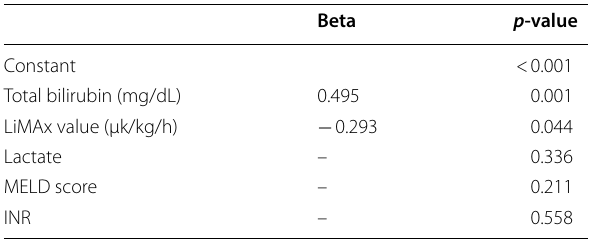
Table 5 Multiple linear regression model: co-factors